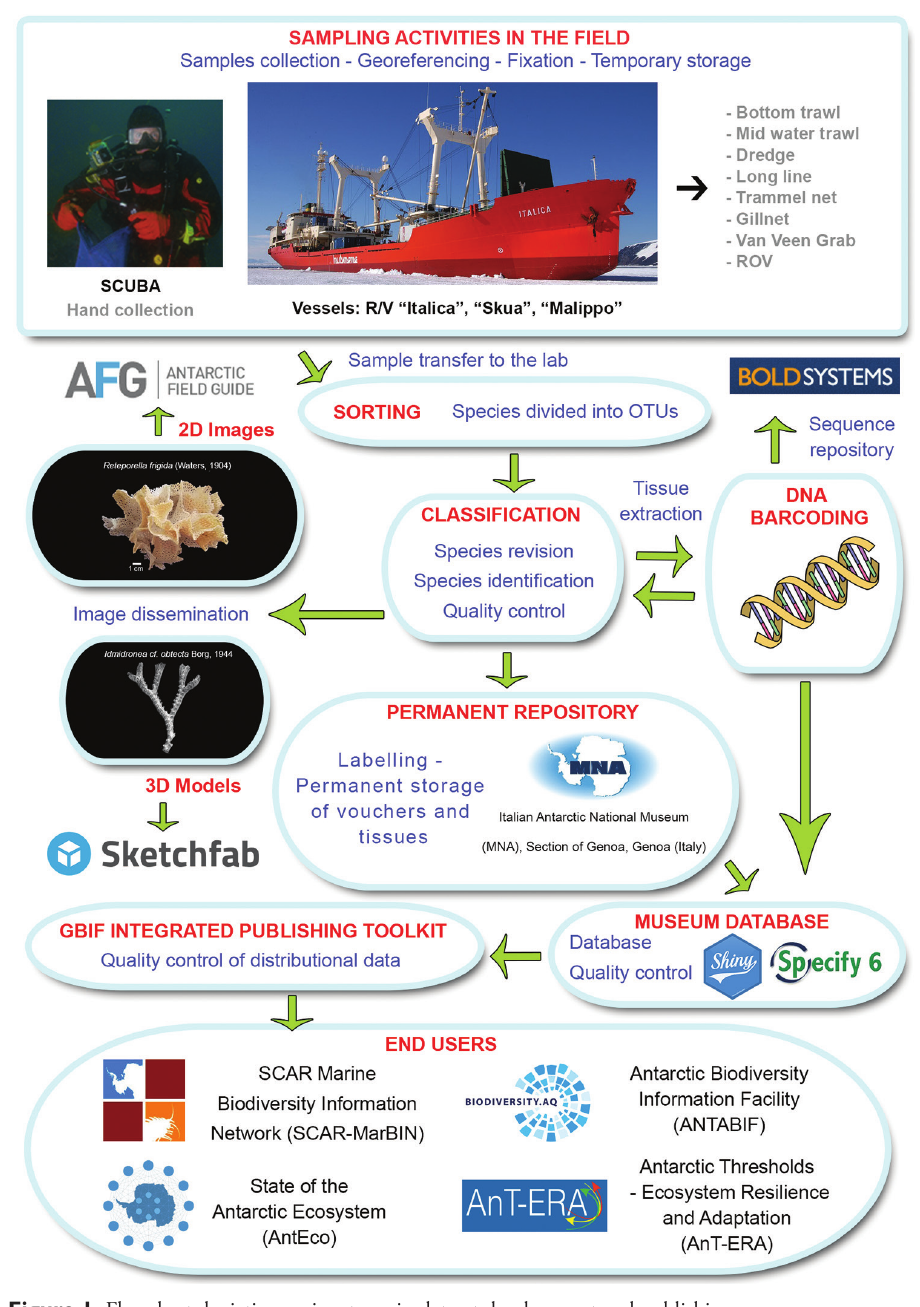
Figure 1. Flowchart depicting major stages in dataset development and